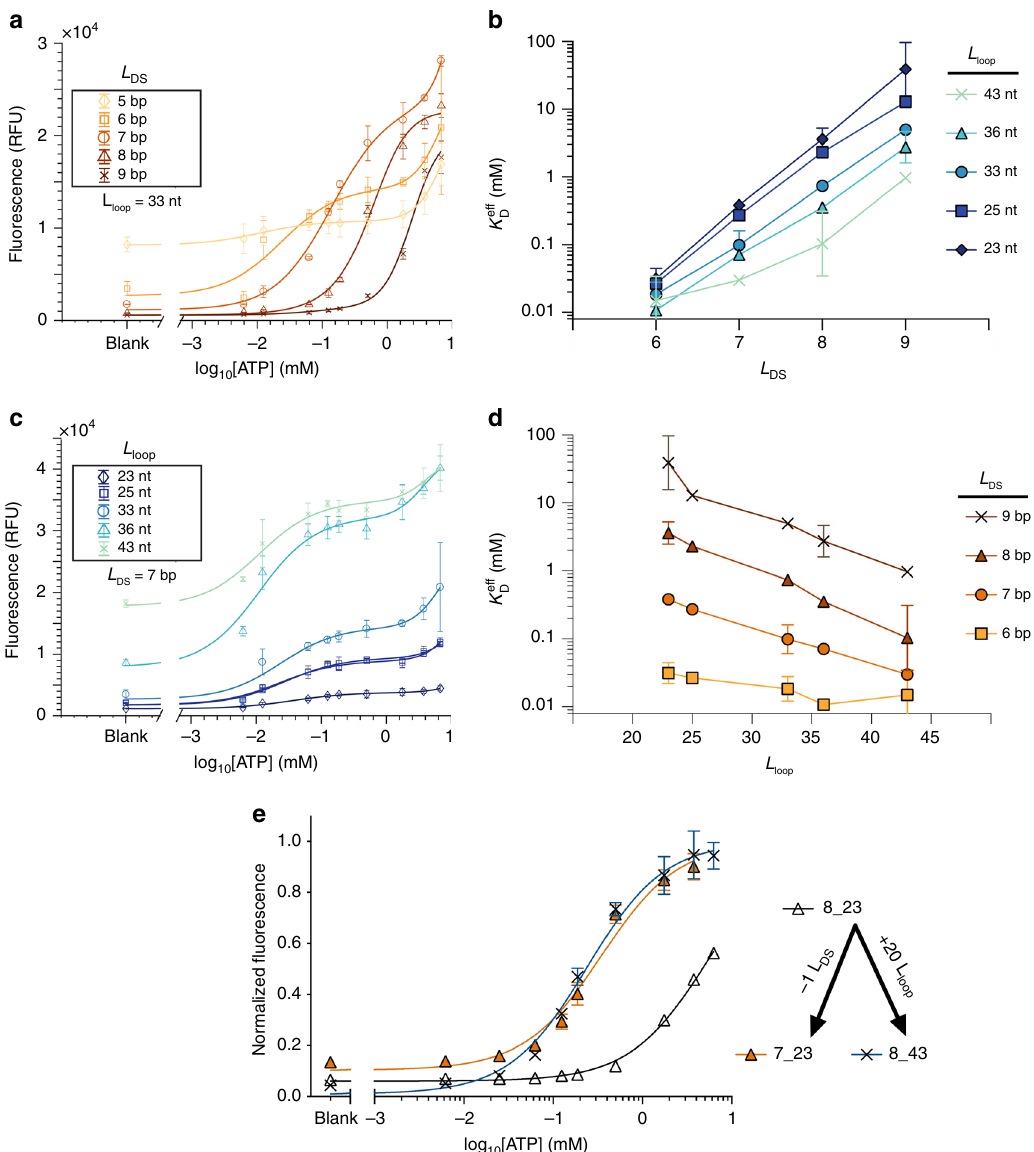
Fig. 3 Binding curve modulation via ISD switch design. a Changing L DS from 5 to 9 bp while maintaining L loop at 33 nt shifts the binding curve to the right and reduces background signal. b K eff increases with L DS given a fi xed L loop . c Changing L loop from 23 to 43 nt while holding L DS constant at 7 bp shifts D